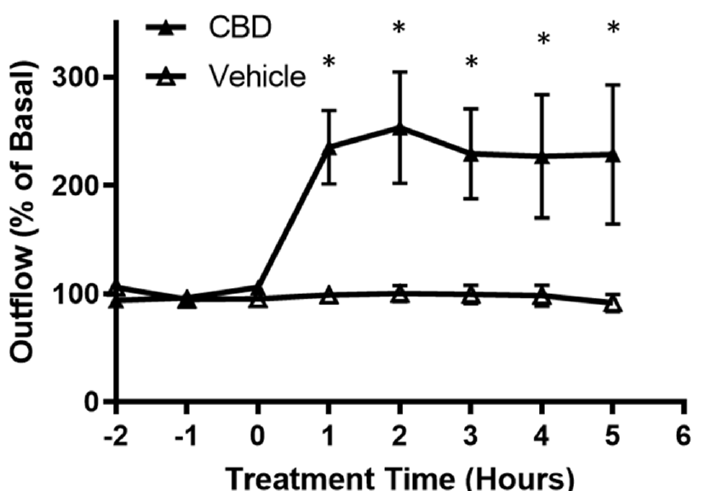
Figure 1. Effects of cannabidiol on aqueous humor outflow. Application of 1 µM CBD caused a significant increase in aqueous humor outflow lasting from 1 h to 5 h. Basal outflow is defined as the average outflow of the three time points prior to CBD administration. Results are expressed as mean ± SEM; n = 10. * Significant differences between 1 µM CBD and vehicle (DMEM + 0.001% ethanol) determined by t -test, p < 0.05.